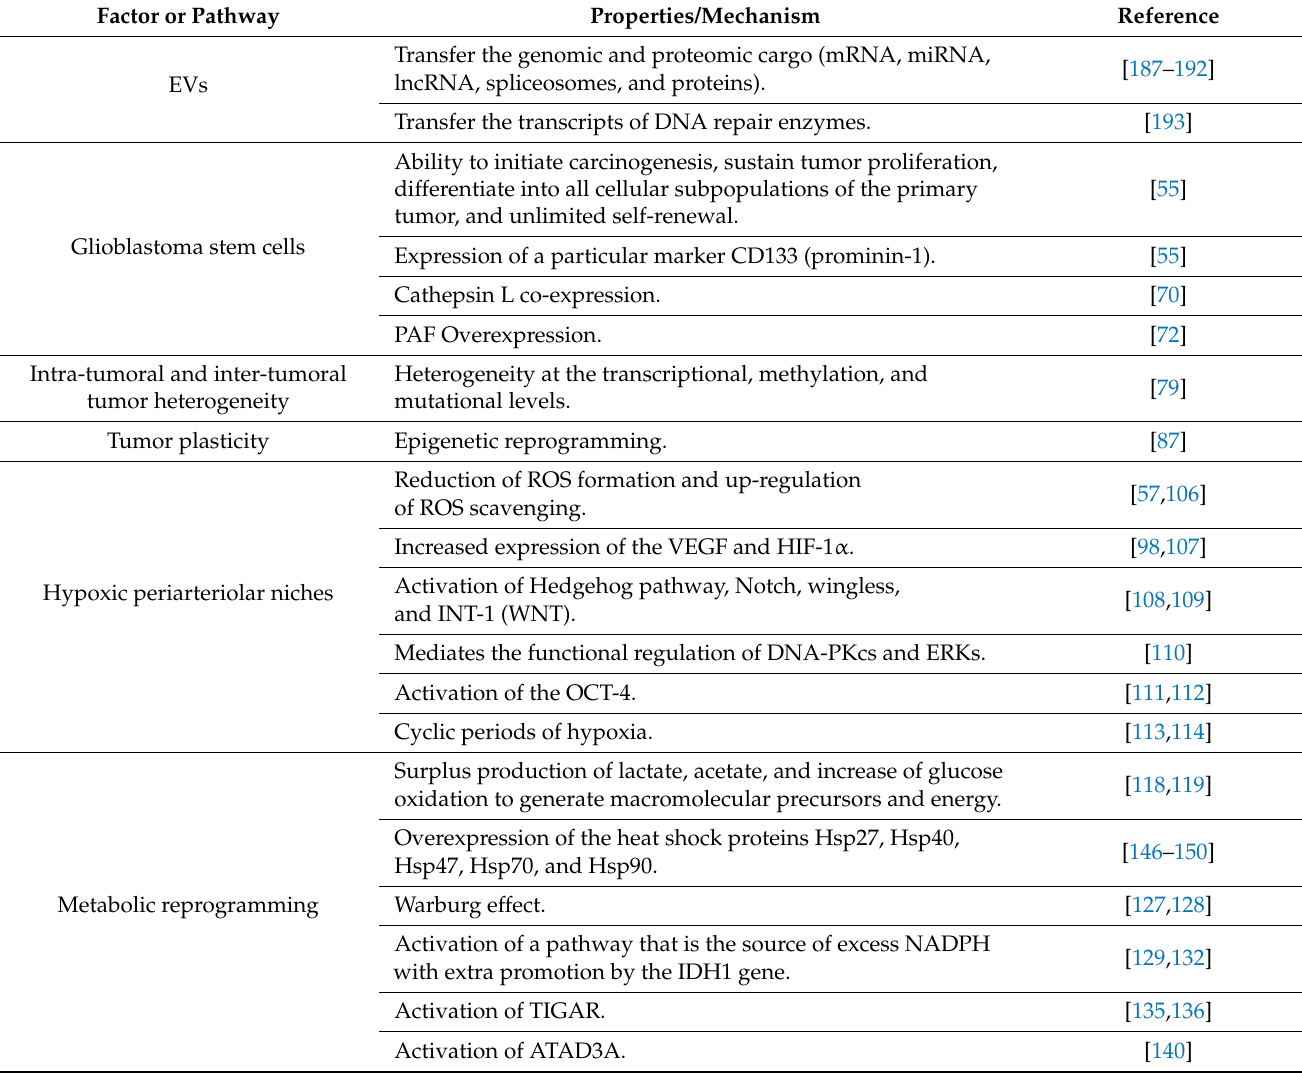
Table 2. Factors and pathways involved in GMB resistance to radiation